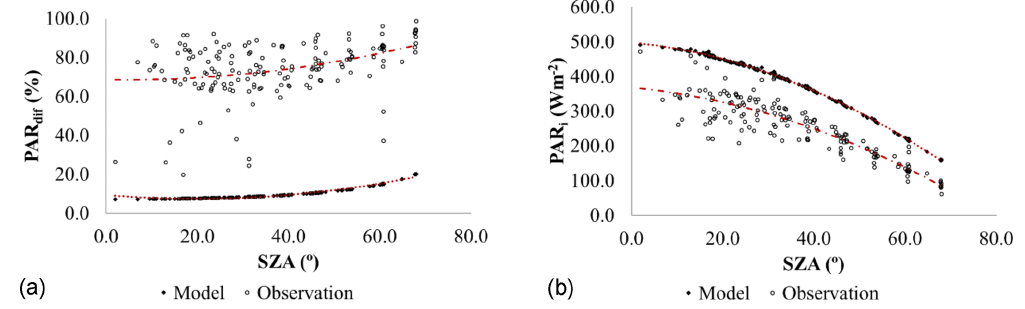
Figure 7. PAR dif (%) (a) and PAR i (Wm − 2 ) (b) versus SZA ( ◦ ), for Rebio Jaru. The observed values of PAR i and PAR dif – obtained by the method of Reindl (1990) – are represented by open circles, while the values calculated through libRadtran with AOD = 0 are represented by the black dots. The curves fitted to the datasets are shown in red. Table 3. Mean values with standard deviations of the turbulent fluxes of CO 2 (FCO 2 ), sensible heat ( H ), and latent heat ( LE ), in µmolCO 2 per square meter per second and watts per square meter, respectively. These values were used as input parameters for building ANNs (measured), mean values and standard deviations generated from the aerosol free scenarios (modeled), and relative differences (%) between the measured and the modeled values for all three study sites. Study site Variables Measured Modeled Relative